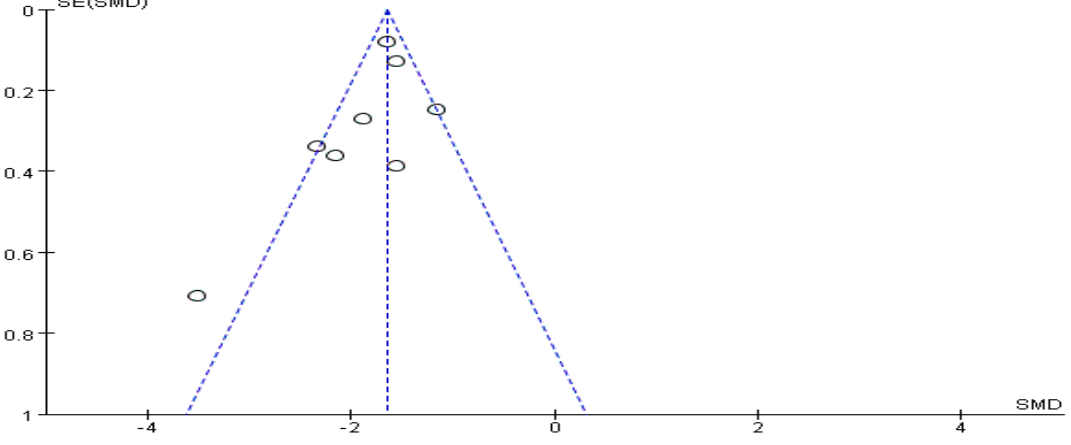
Figure 6. Funnel plot for publication bias of highlight behavior.